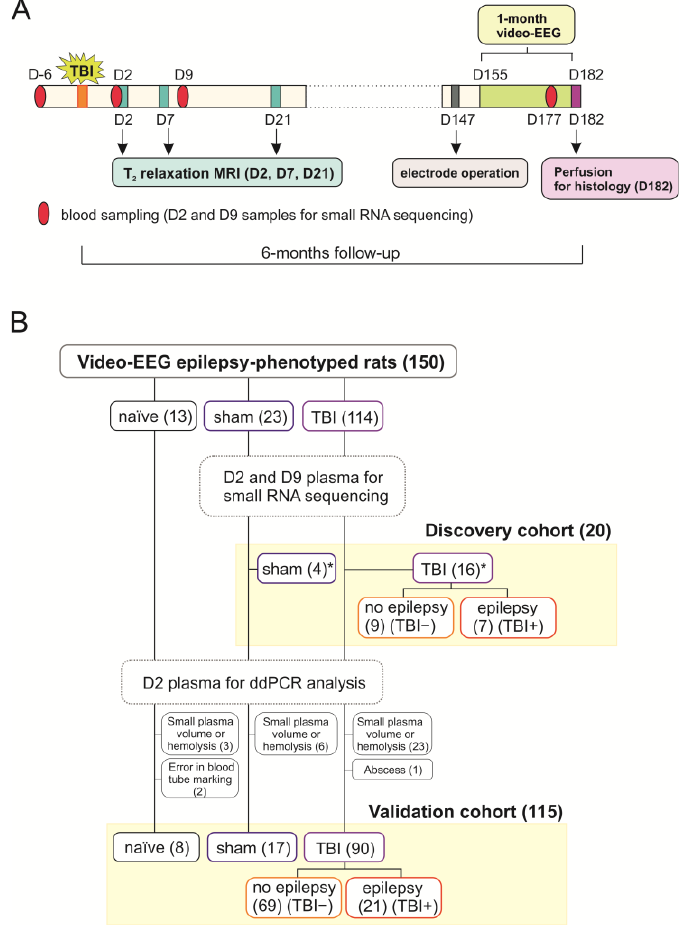
Figure 11. Study design and animal numbers. ( A ) Traumatic brain injury (TBI) was induced in rats by lateral fluid percussion injury. Sham-operated experimental controls underwent the same surgery, including craniotomy without TBI induction. Blood was collected from the tail vein 6 d before (D-6) the injury or sham operation, and then on D2, D9, and D177 after injury. Animals underwent T2 magnetic resonance imaging (MRI) on D2, D7, and D21 to measure cortical lesion volume. To monitor the occurrence of spontaneous seizures (i.e., to diagnose PTE), rats were continuously monitored with vEEG (24/7) for 1 month during the sixth post-injury month. ( B ) A total of 150 animals (13 naïve, 23 sham, 114 TBI) of the EPITARGET cohort were epilepsy-phenotyped using vEEG. Then, D2 and D9 plasma of 20/150 rats, including 4 sham and 16 TBI animals (7 with epilepsy [TBI+], 9 without epilepsy [ TBI− ]) were used for small RNA sequencing (discovery cohort). The discovery cohort included samples from the first 20 epilepsy-phenotyped rats with acceptable sample quality and sample volume sufficient for small RNA sequencing (see Methods). Validation of miRNA-sequencing data using ddPCR was performed in the plasma of 115 rats [validation cohort; 8 naïve, 17 sham, and 90 TBI animals (21 TBI+, 69 TBI − )]. Abbreviations: D, day; vEEG, video-electroencephalography; *, 2 samples from sham-operated and 5 samples from injured animals (3 TBI − , 2 TBI+) that were used for small RNA sequencing in the discovery cohort were also included in the ddPCR analysis in the validation